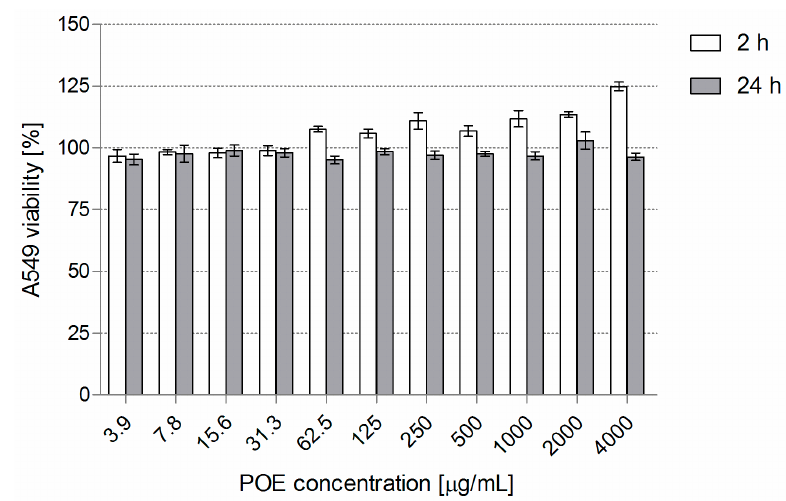
Figure 4. Cytotoxic effect of POE used at a concentration range of 3.9–4000 µ g/mL on human lung epithelial cell line A549 (exposure time: 2 h and 24 h), tested by MTT-reduction assay. The mean cell viability (% of cell viability ± S.D.) compared with positive control (untreated cells) considered as exhibiting 100% viability is presented.